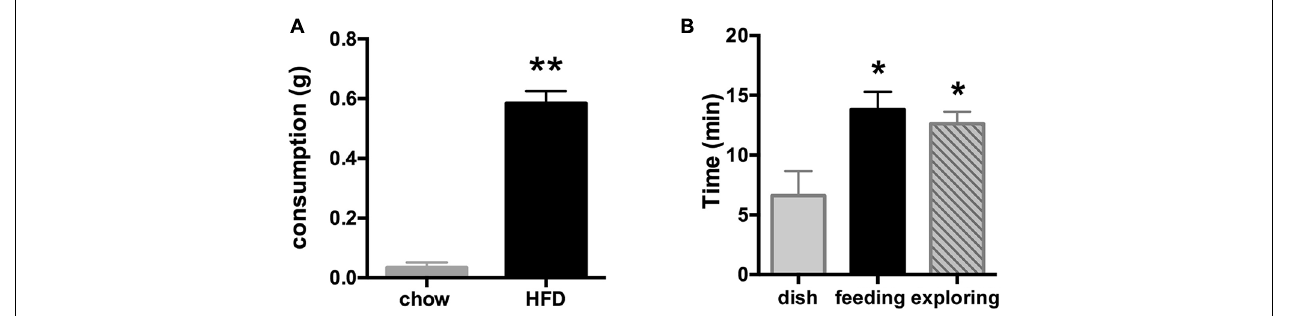
FIGURE 1 | (A) Consumption of the palatable HFD (elevated fat and sugar content), but not of regular rodent chow is indicative of a hedonic rather than a metabolic drive. Food was offered shortly after light onset for 30 min starting at ZT = 0.5–1.5 h. ** p < 0.001 ( n = 6/group). (B) Introduction of HFD at ZT = 0.5–1.5 h led to a significant increase in amount of time spent on